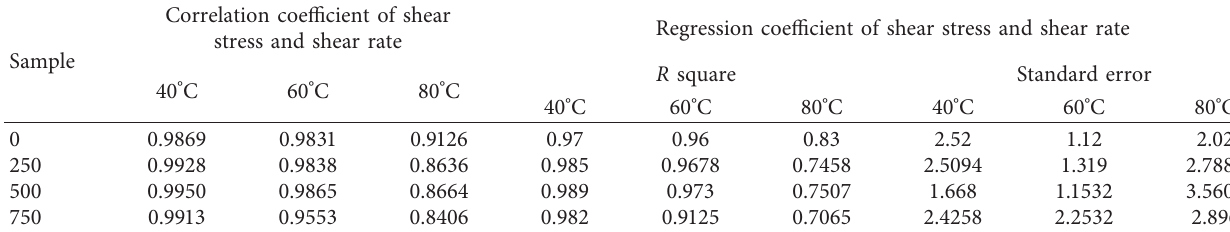
Table 7: Correlation and regression analyses between viscosity and shear rate.